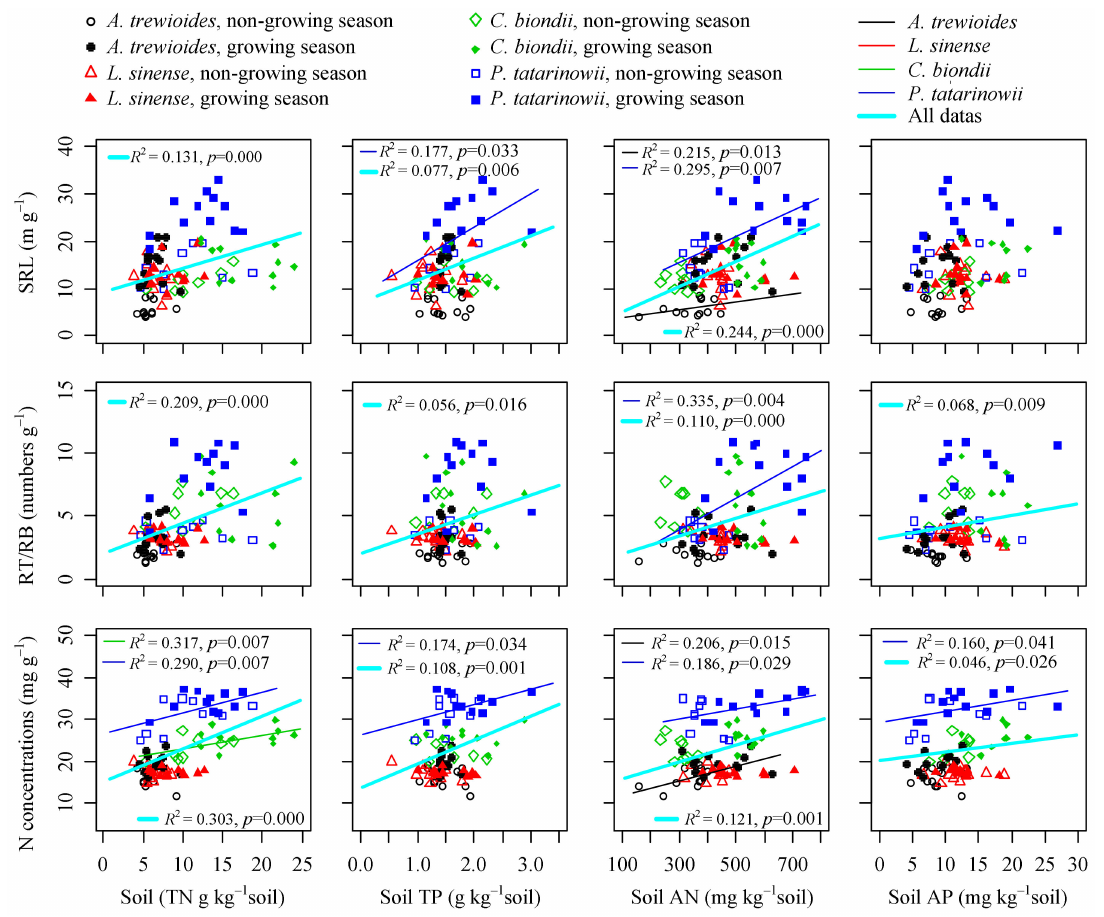
Figure 4. Relationships between fine root traits (SRL, RT/RB, and N concentration) and soil nutrients concentrations and availabilities in a karst ecosystem of southwest